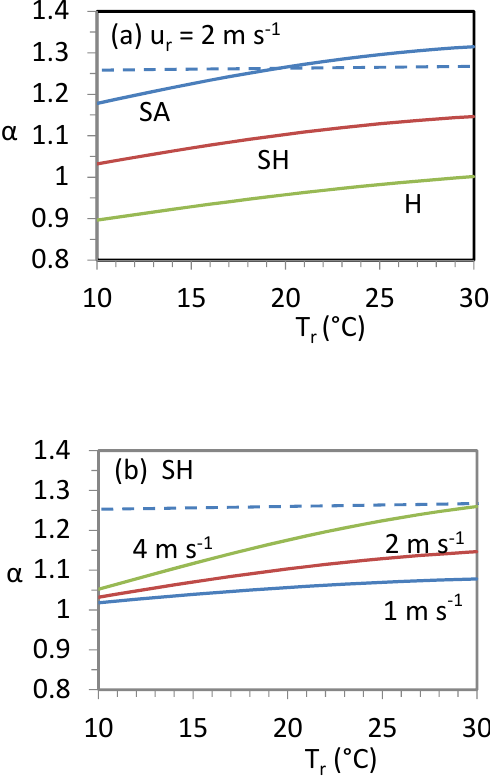
Figure 1. Value of the coefficient α inferred from Eq. (15) as a func- Fig. 1- Value of the coefficient α inferred from Eq. (15) as a function of air temperature at reference 4 tion of air temperature at reference height, the straight dotted line height, the straight dotted line representing the "preferred" value 1.26: (a) for different climatic 5 representing the “preferred” value 1.26: (a) for different climatic conditions (see Table 1) with u r = 2 m s -1 ; (b) for different values of wind speed under sub-humid 6 conditions (see Table 1) with u r = 2ms − 1 ; (b) for different values conditions (SH). 7 of wind speed under sub-humid conditions